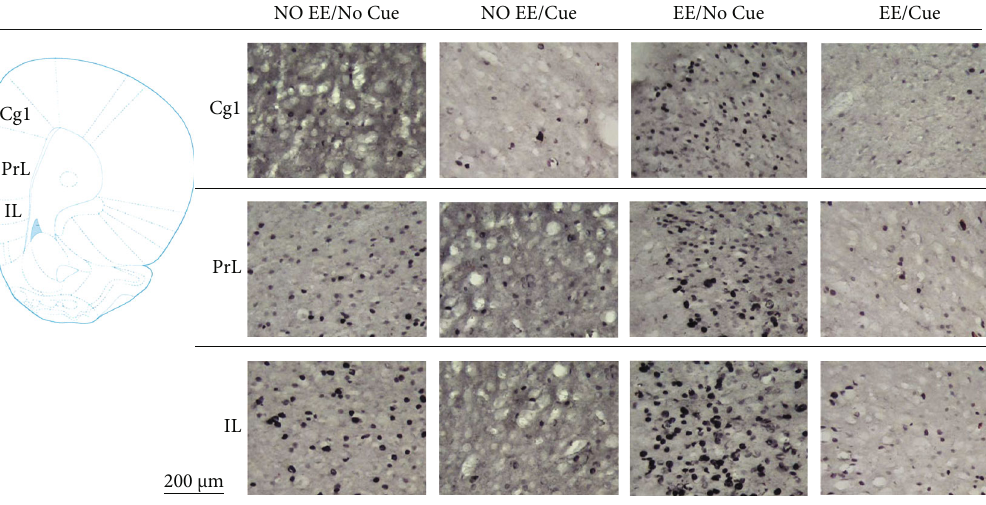
Figure 8: (a) A schematic brain atlas for the Cg1, PrL, and IL of the mPFC. (b) Representative photomicrographs of the c-Fos expression for the Cg1, PrL, and IL in the no EE/no cue, no EE/cue, EE/no cue, and EE/cue groups ( n = 4 , per group). Scale bar represents 200 μ